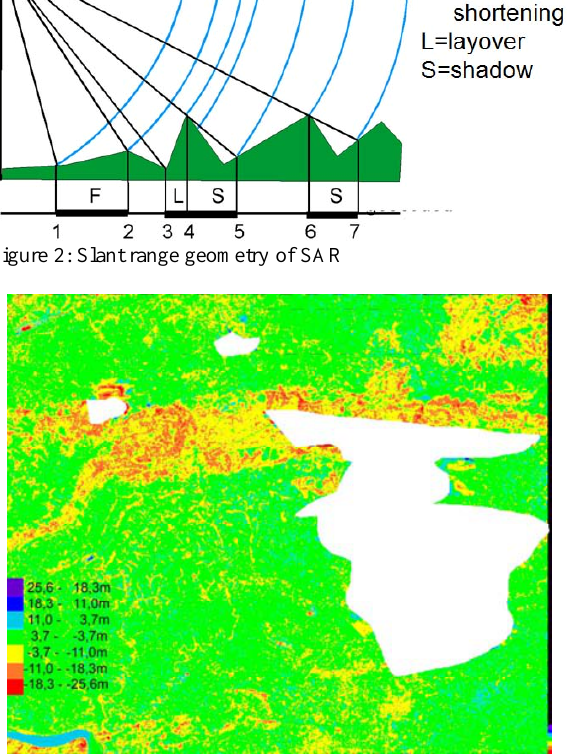
Figure 3: color coded height differences SRTM DSM against reference DTM, Pennsylvania – white = no data